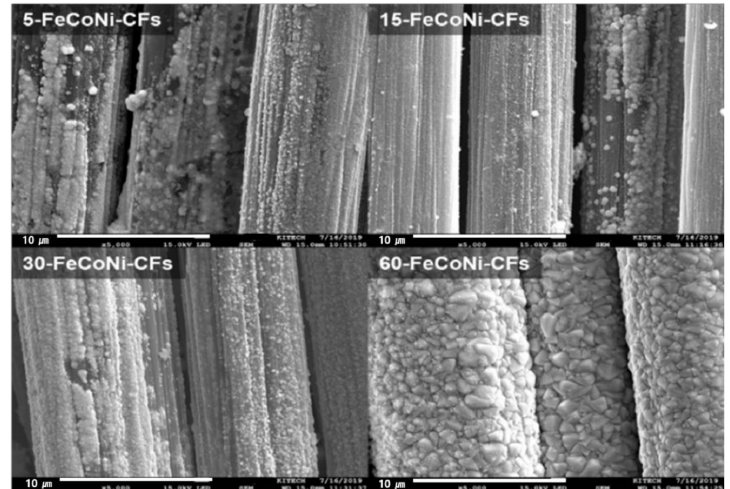
Figure 3. SEM images of the 5-, 15-, 30-, and 60-FeCoNi-CFs.